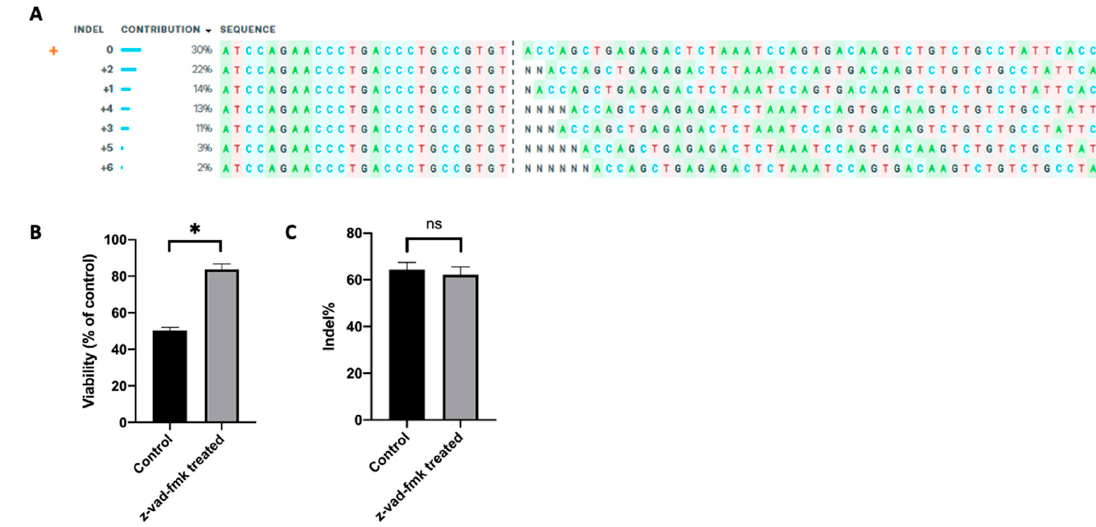
Figure 7. Effects of apoptosis inhibition on cell viability and indel frequency in Jurkat cells. The gene-editing was achieved through electrotransfer of a ribonucleoprotein (RNP) targeting the T cell receptor- α constant (TRAC) gene. ( A ) Inference of CRISPR Edits (ICE) analysis, showing the outcome of TRAC editing in Jurkat cells; ( B ) cell viability measured at 24 h; ( C ) indel within the TRAC gene determined at 48 h post electrotransfer using TIDE analysis. Pulsing condition: 650 V/0.2 cm, 300 µs, 2 pulses, 10 Hz. ns, non-significant. Error bars, SEM; * p < 0.05, Student’s t -test, N = 6.